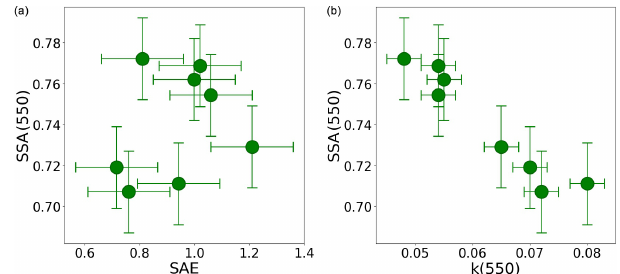
Figure 8. Contribution to single scattering albedo (a) from particle size (assessed via SAE) and (b) from composition (assessed via k ) in biomass burning